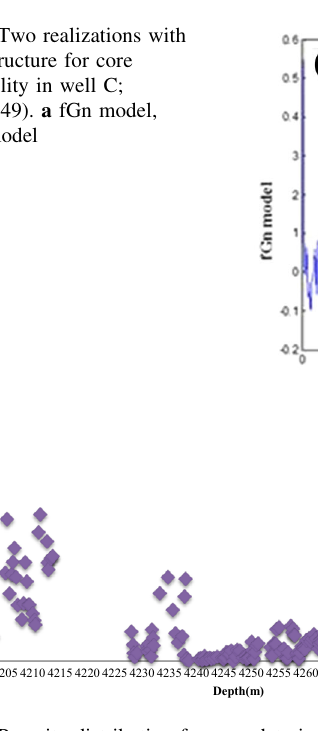
Fig. 11 Porosity distribution for core data in well C